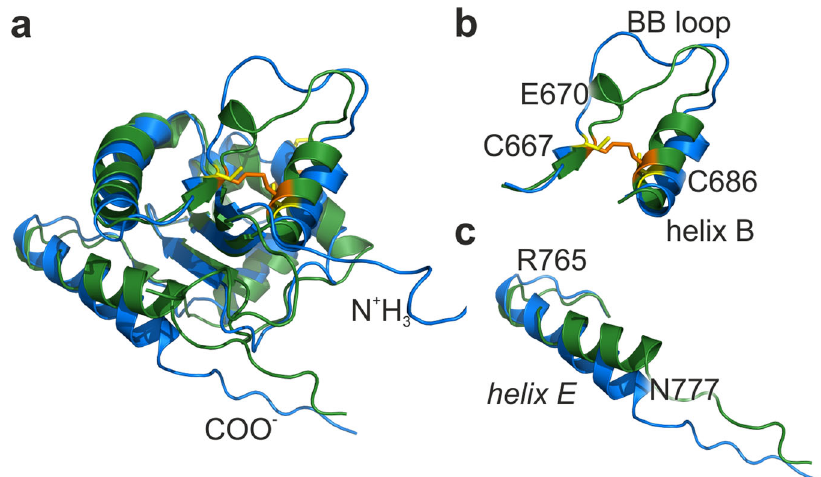
Fig. 2 Superposition of NMR and X-ray structures. a Overlay of TLR1-TIR structures obtained by NMR spectroscopy (blue and yellow) and X-ray crystallography (green and orange). b , c Overlay of TLR1-TIR regions with the most signi fi cant structural changes caused by the closure of a disul fi de bond (yellow and orange colors,